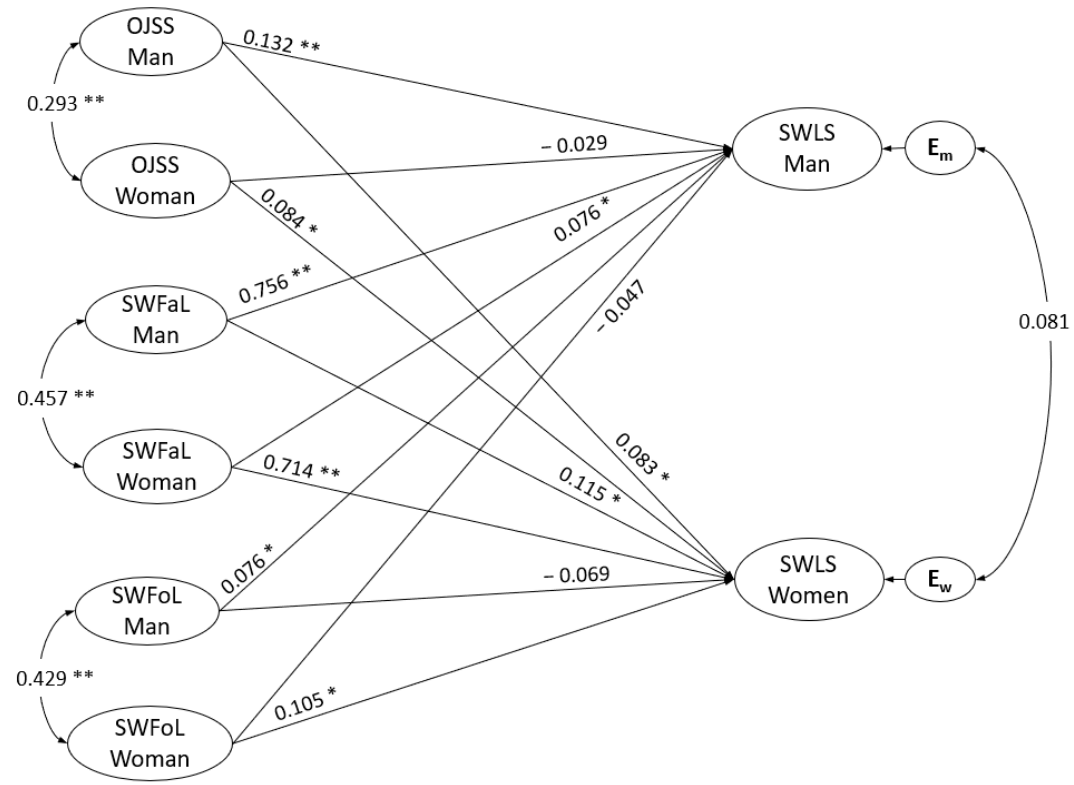
Figure 2. Actor–partner interdependence model of the e ff ect of Overall Job Satisfaction Scale (OJSS), Satisfaction with Family Life (SWFaL) and Satisfaction with Food-related Life (SWFoL) on Satisfaction with Life (SWLS) in dual-earner couples. Em and Ew: residual errors on SWLS for the man and woman, respectively. * p < 0.05, ** p < 0.01. The control for the e ff ects of number of children and family socioeconomic status on the dependent variables of the members of the couple (SWLS) was not shown in the path diagram, so as not to overload the figure.